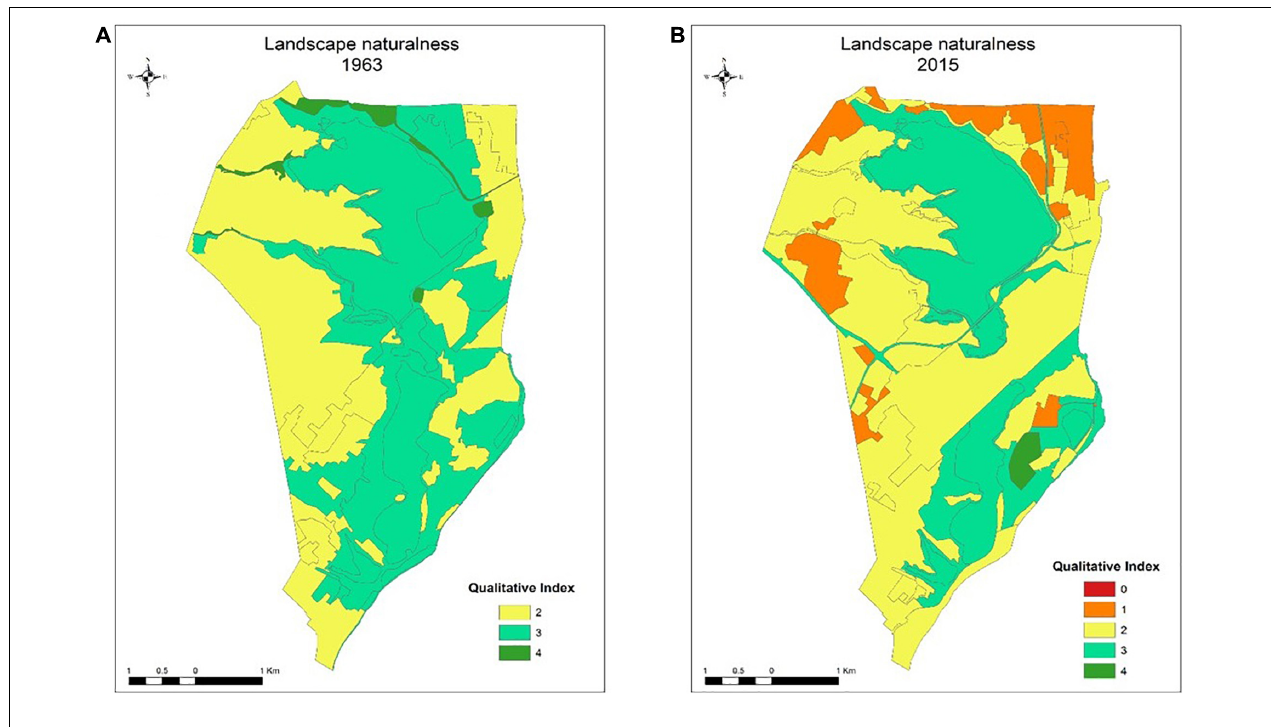
FIGURE 6 | Landscape naturalness and its changes between 1963 (A) and 2015 (B) .